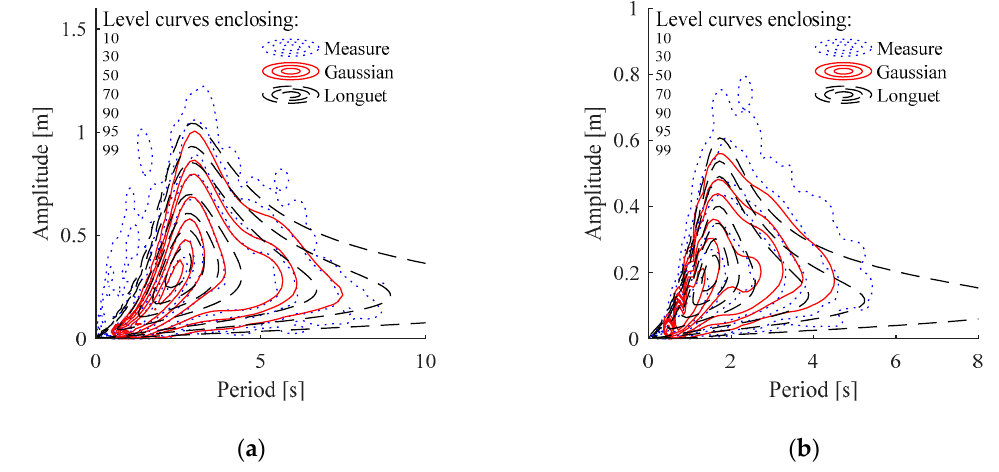
Figure 14. Joint density of wave amplitude and corresponding periods of measured data and the Gaussian and Longuet-Higgins models for ( a ) H s = 1.0583 m and ( b ) H s = 0.6069 m. The Longuet-Higgins model was only used for the amplitude and period, so only the Gaussian model was used for the joint distribution of the maximum and corresponding local minimum. The